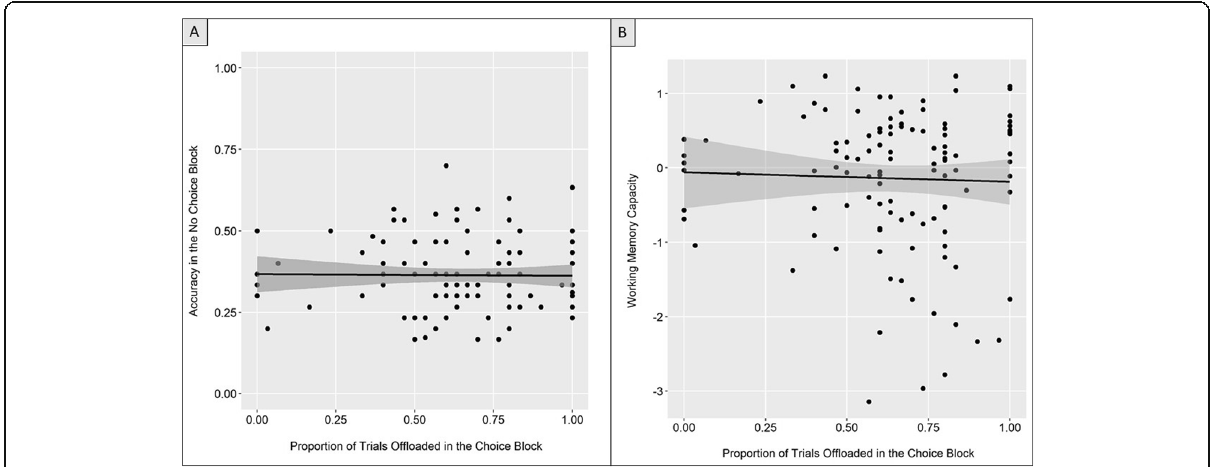
Fig. 4 Scatter plots examining memory performance and offloading behavior. a Performance on the no-choice block and frequency of offloading. b Working memory, capacity, indexed by a composite of performance on complex working memory span tasks, and frequency of offloading. Errors bands represents the 95% confidence